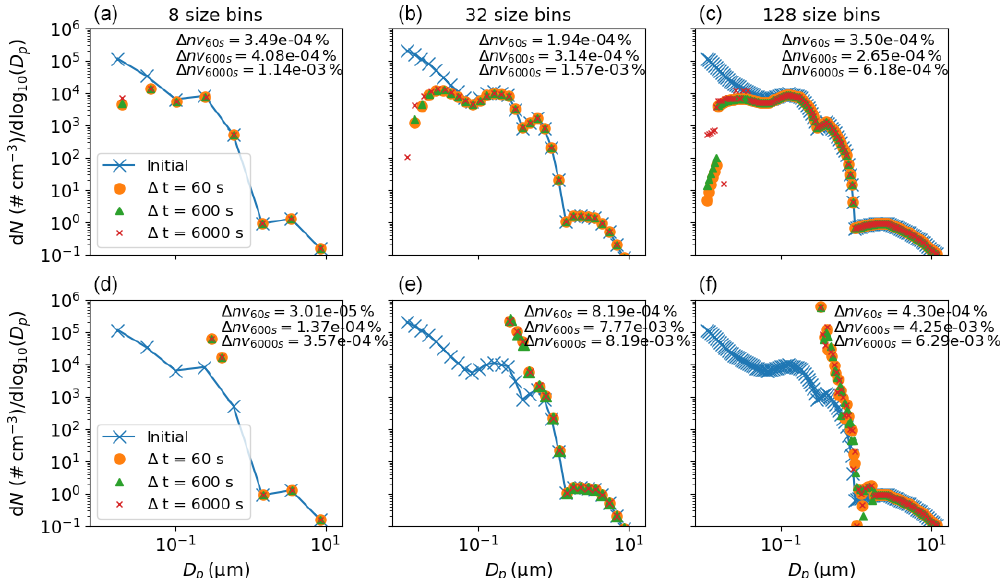
Figure 8. Sensitivity of the coagulation process to changes in the temporal resolution (given in the legend) and number of size bins (given in column titles). In the top row no chemistry occurred, whilst in the bottom row a semi-volatile species was produced, as detailed in the main text. Results are for the end of a simulated 6h experiment. The (cid:49) nv temporal resolution value given in the inset text is the percentage change in total non-volatile particle-phase material from the start to the end of the experiment, demonstrating mass conservation in the